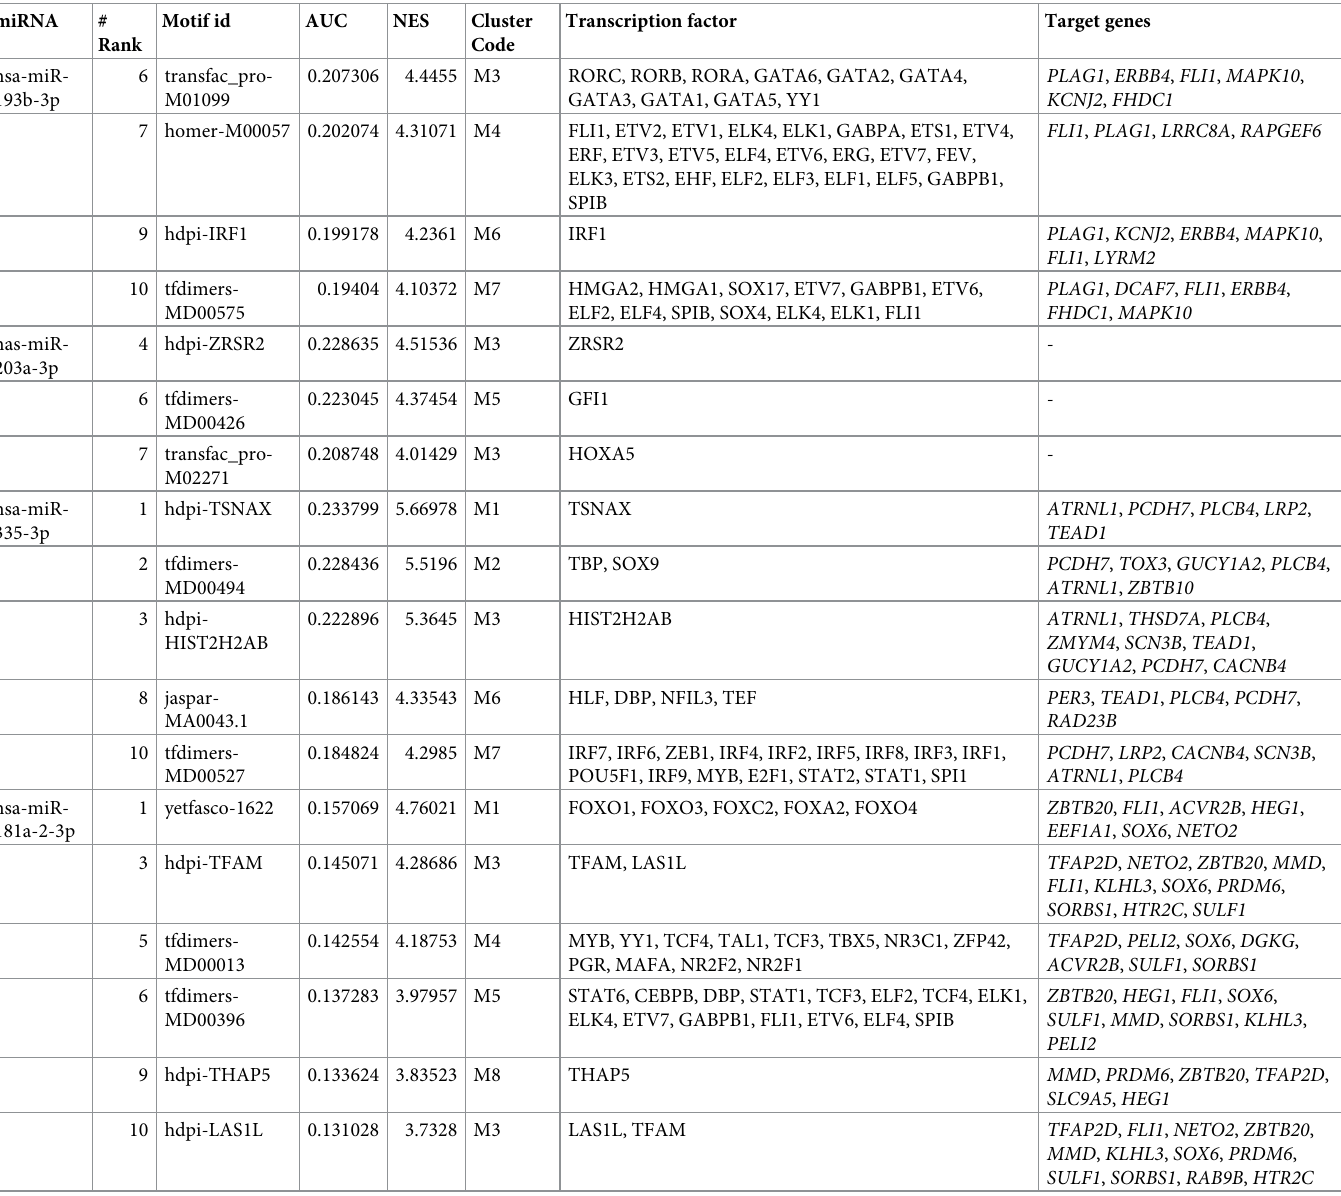
Table 4. The miRNAs, transcription factors and target gene network enrichment